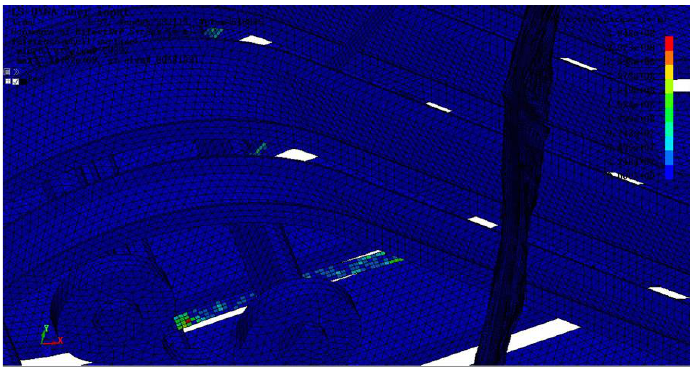
Figure 10. Occurrence of maximum effective stress on elastic teeth.